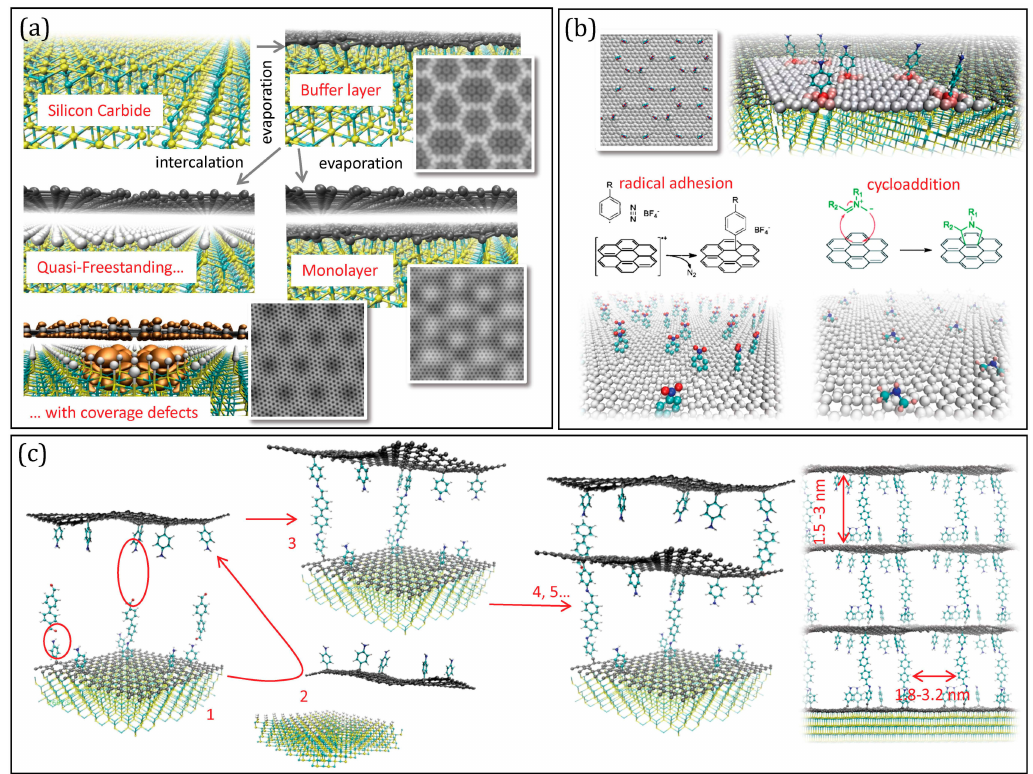
Figure 2. ( a ) Summary of the production of graphenes on SiC: the Bu ff er layer (BL by evaporation of Si), graphene monolayer (GML by subsequent evaporation) and quasi-free-standing monolayer (QFMLG, by intercalation of H or metal). The simulated Scanning Tunnel Microscopy images are reported for the BL, for the ML and for the QFSML with defects in the intercalation coverage layer. ( b ) Scheme of possible functionalization reactions exploiting the corrugation pattern of the BL. ( c ) Scheme of a possible strategy to build pillared multilayers: after pillaring (1), the cross-linking should occur with a previously detached functionalized sheet (2 to 3), and be re-iterated (4, 5 ... ) to give a regular